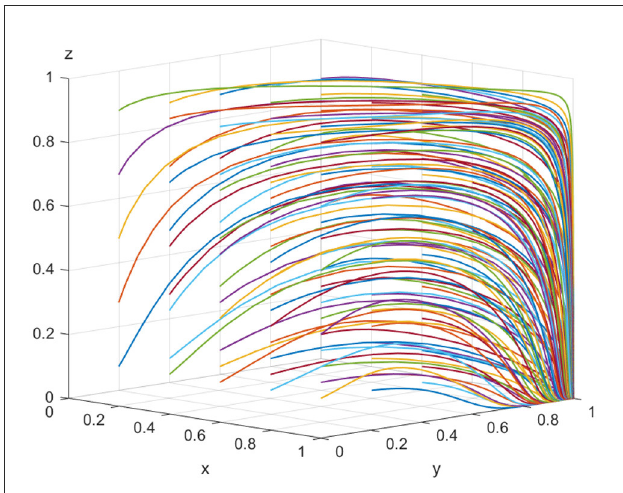
FIGURE3 Simulation diagram of the system evolution 50 times under array 1.